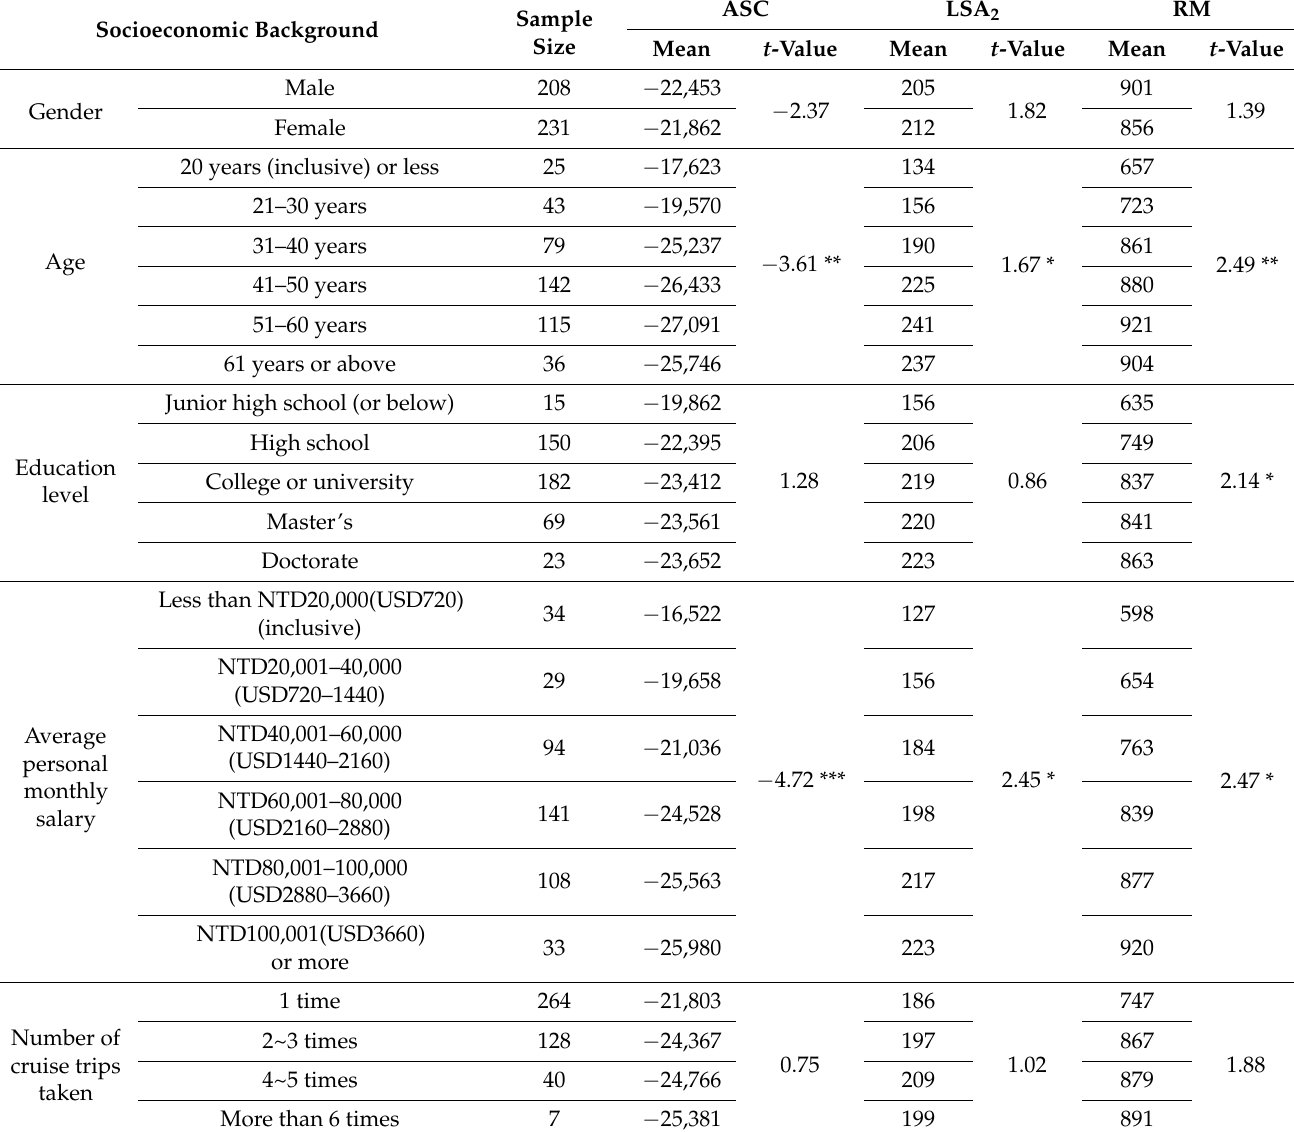
Table 4. Comparison of respondents’ socioeconomic background and MWTP for cruise tour attributes. Socioeconomic